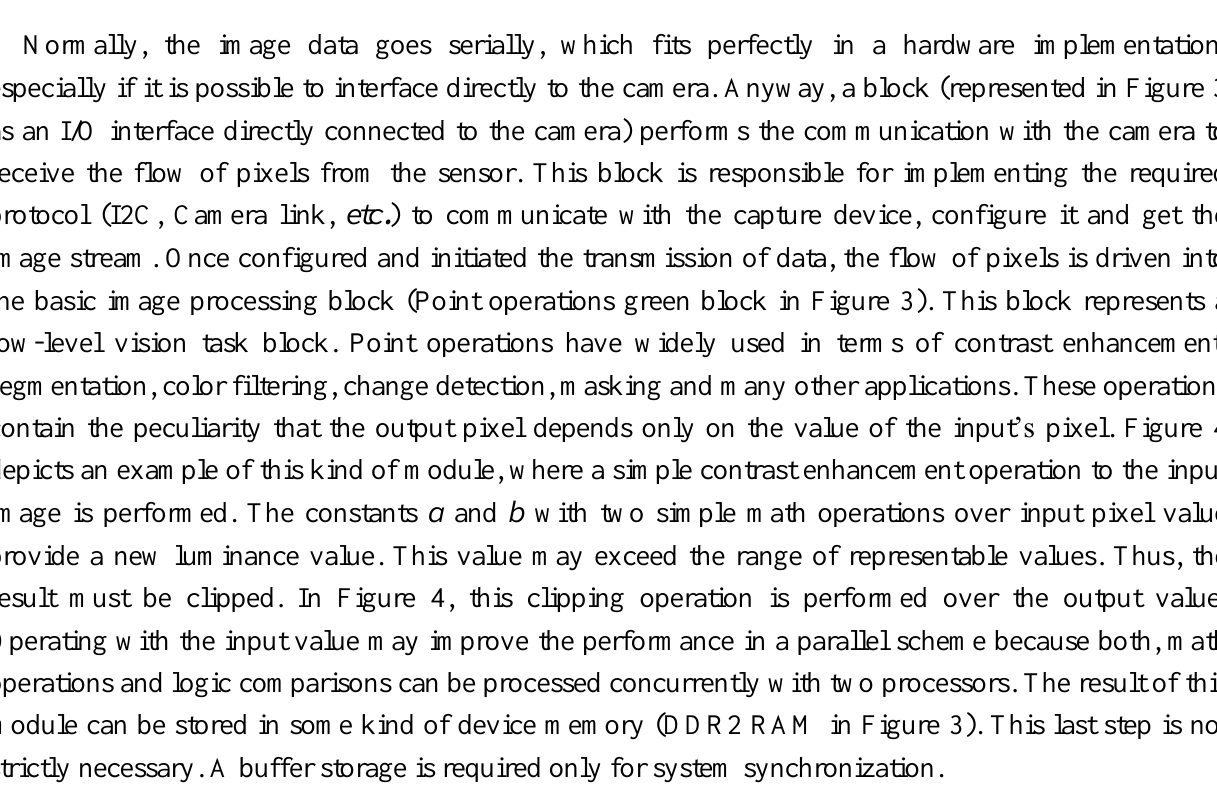
Figure 4. Basic point operation on an FPGA. Input pixel luminance value is multiplied by the constant a , and then summed with the constant b . The value obtained is clipped before storing the new Q value of the